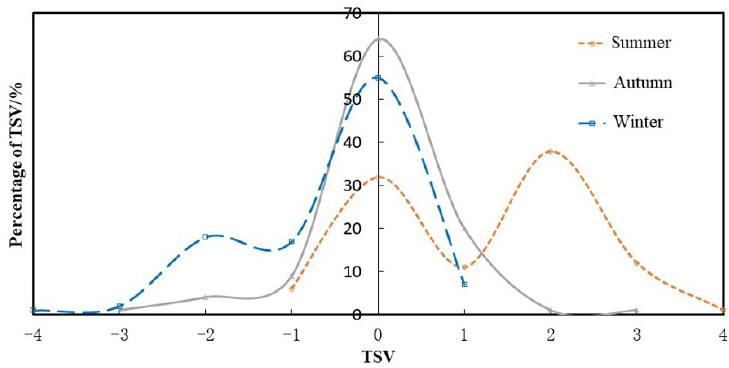
Figure 3. The percentage of TSV in the summer, autumn, and winter.